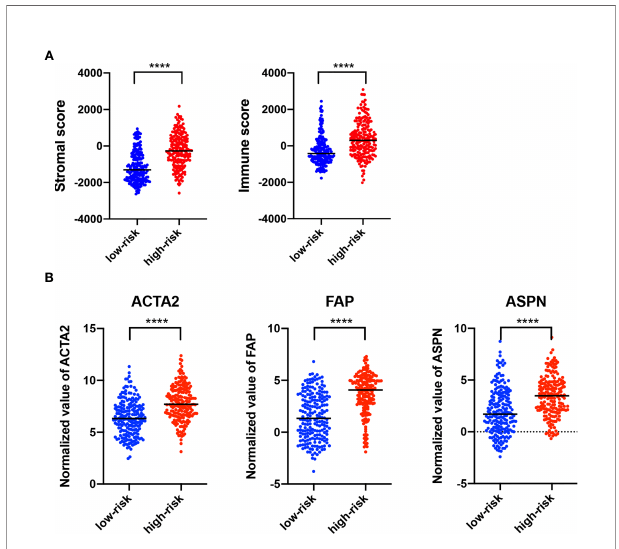
FIGURE 6 | Characterization of Stromal and immune in fi ltration based on the lncRNA signature. (A) ESTIMATE analysis (version 1.0.13, https://